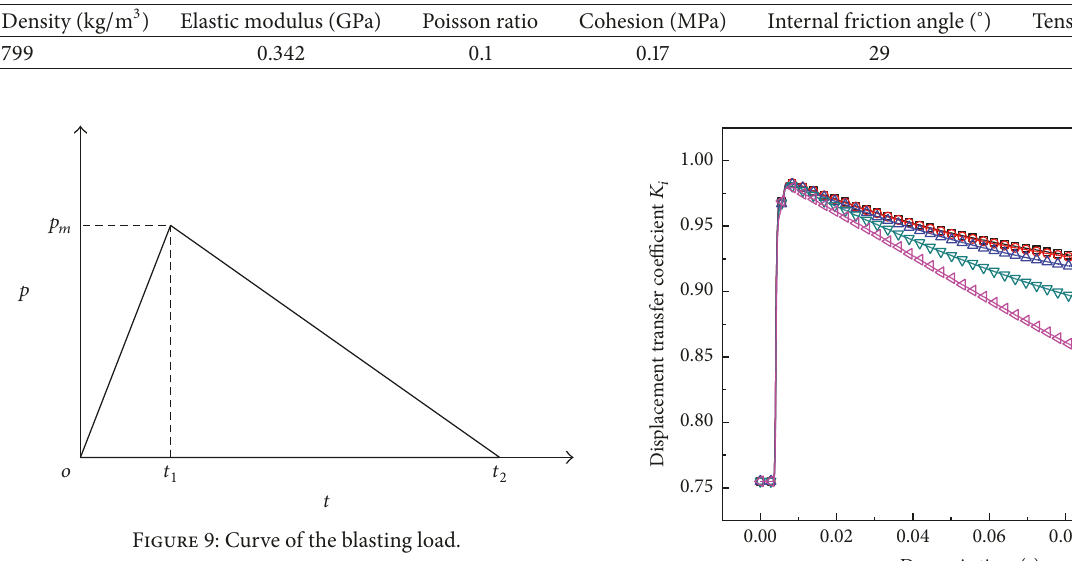
Table 3: Mechanical parameters for foam concrete.